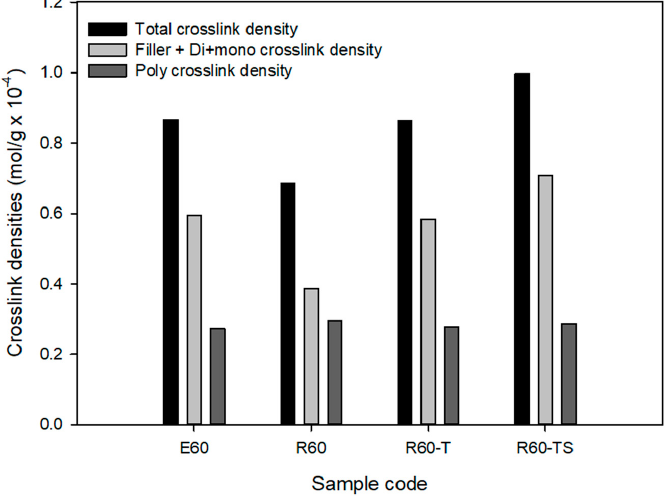
Figure 10. Cure characteristics of carbon black-filled compounds with a controlled cure system.